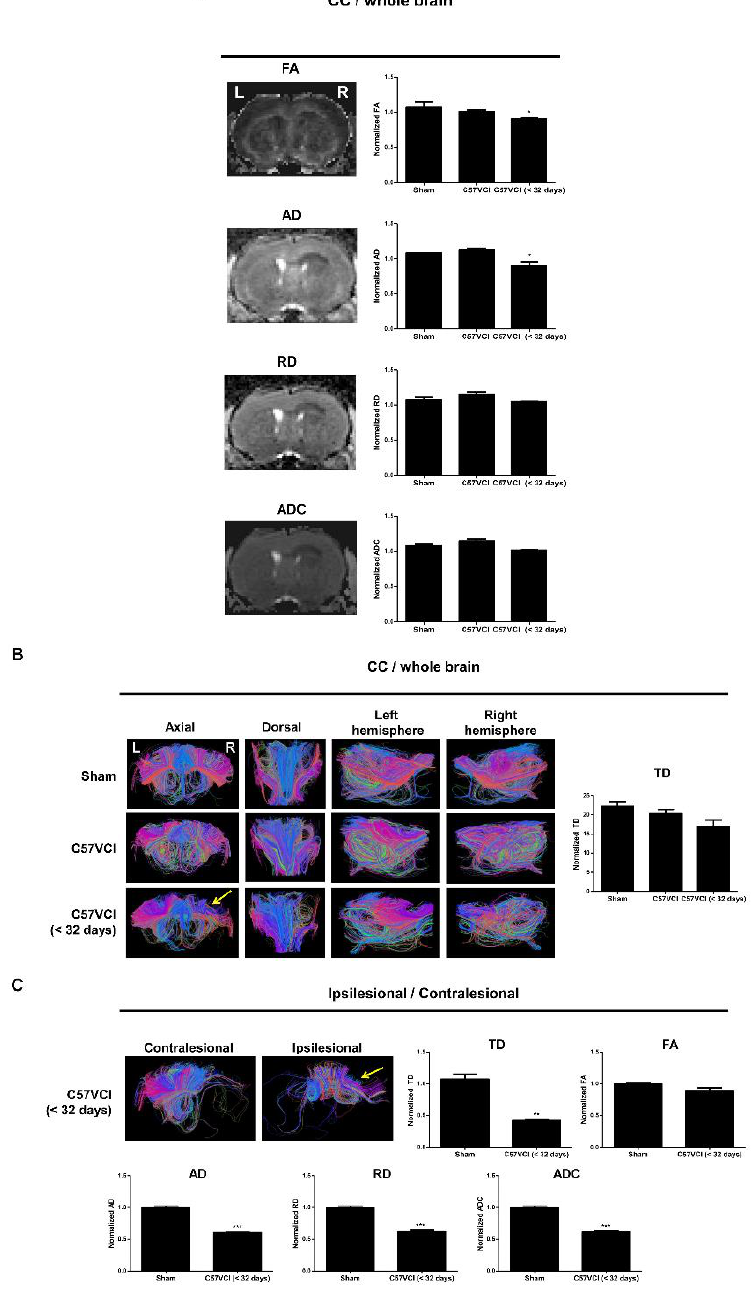
Figure 4. The effects of VCI on Diffusion Tensor Imaging (DTI) parameters. ( A ) Tract Density (TD), Axial Diffusivity (AD), Radial Diffusivity (RD), and Apparent Diffusion Coefficient (ADC) maps of the corpus callosum (CC) from a representative animal (far left). The normalized values of the CC (the CC value were divided by the value of the whole brain) were used for group comparisons: Sham, C57VCI (sacrificed at 32 days), and C57VCI < 32 days are shown in bar graphs on the right. * p < 0.05 vs. sham; mean ± S.E.M. L indicates left and R indicates the right hemisphere of the mouse brain. ( B ) Tractography of a representative animal from each of the groups (from left to right: axial, dorsal, left hemisphere, right hemisphere) and the normalized (CC/whole brain) tract density shown as bar graphs. The solid yellow arrows indicate reduced fiber density. ( C ) Normalized DTI parameters (the value on the side of the infarct was divided by the value of the contralesional side of the C57VCI <32 days group) quantitated by comparing the ipsilesional to the contralesional side of the C57VCI <32 days group. ** p < 0.01, *** p < 0.001 vs. contralesional; mean ± S.E.M. Three C57VCI mice that died before the 32 days with cerebral infarcts (C57VCI <32 days: C57VCI